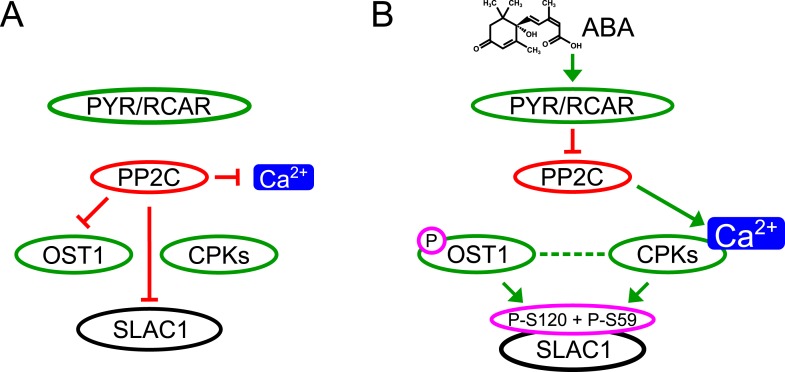
Simplified schematic model for Ca2+-specificity mechanism within ABA-dependent SLAC1 activation in guard cells.(A) Without ABA, Ca2+ elevations that can also function in stomatal opening responses (Irving et al., 1992; Shimazaki et al., 1992; Curvetto et al., 1994; Shimazaki et al., 1997; Cousson and Vavasseur, 1998; Young et al., 2006) and spontaneous or un-specifically induced Ca2+ transients (Allen et al., 1999b; Klüsener et al., 2002; Young et al., 2006; Yang et al., 2008; Siegel et al., 2009) do not lead to S-type anion channel (SLAC1) activation as PP2C protein phosphatases directly negatively regulate SLAC1 activation. (B) In the presence of ABA this SLAC1 inhibition is released, OST1 and CPKs phosphorylate, and thereby activate the channel. ABA also causes [Ca2+]cyt elevation via PP2C inhibition (Allen et al., 1999a; Murata et al., 2001). Data indicate cross-talk between Ca2+-dependent and -independent ABA-activation of SLAC1 which may be mediated through a combination of protein kinase cross regulation and additive activation via differential affinities for SLAC1 phosphorylation sites by OST1 and CPKs.